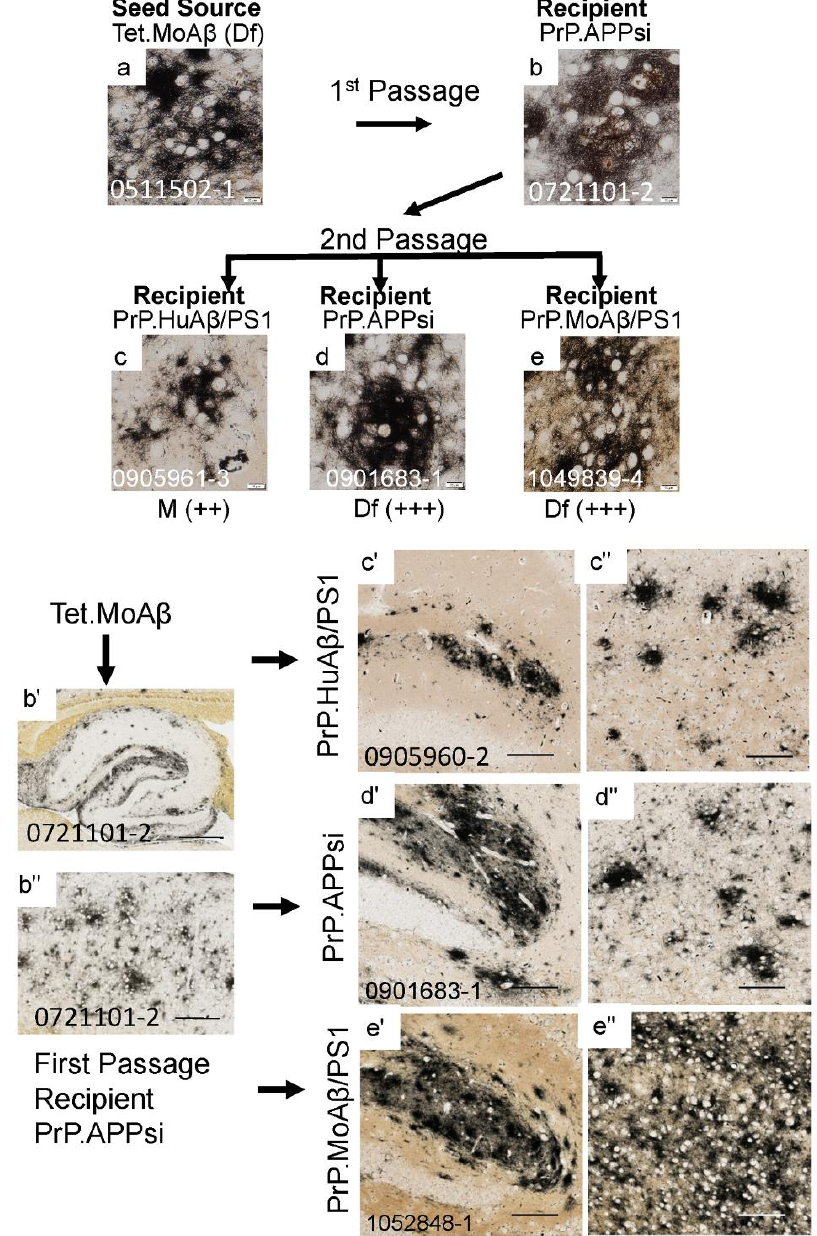
Figure 2. Serial passage of diffuse Aβ pathology through a PrP.APPsi host. The upper panels show high- power images of Aβ deposit morphology from C -S silver staining in the brain of the seed source animal, the brain of the first passage recipients, and the brains of the second passage recipi- ents. Aβ pathology was confirmed by Aβ immunostaining ( Figure S2). The scoring criteria for pa- thology are described in the legend to Figure 1 The lower panels show low-power views of the seeded animals. Details of animal numbers for each injection are provided in Table 3 and Table S2. ( a ) Image from the cortex of the original seed source Tet.MoAβ animal [26]. ( b , bʹ , bʹʹ ) Images from the recipient PrP.APPsi mouse used as host for Passage 1 (aged 12 months before harvest). ( c , cʹ , cʹ ʹ– e , eʹ , eʹ ʹ). Representative images of brain from recipients seeded with first passage brain from PrP.APPsi mice ( b , bʹ , bʹʹ ). In the upper panel, below each row of images from the second passage seeded animals, there is information on pathological rating (Df = diffuse; Cr = cored) and relative severity, using the same scoring system as in Figure 1. ( a – e ) Images of cortex. ( bʹ – eʹ ) Images of hip- pocampus. ( bʹʹ – eʹʹ ) Images of cortex. ( a – e ) Images of amyloid plaques in cortex taken by microscope with 40× objective lens, scale bar =10µm. ( b ʹ – e ʹʹ ) Images of hippocampus or cortex cropped by Ape- rio system scanned images (20×). ( b ʹʹ ) Image of hippocampus, scale bar = 500µm. ( b ʹʹ ) Image of cor- tex, scale bar = 200µm. ( c’ , d’ , e’ ) images of hippocampus and ( c ʹʹ , d ʹʹ , e ʹʹ ) images of cortex, cropped at 1000 × 1000 pixels, scale bar = 100µm.